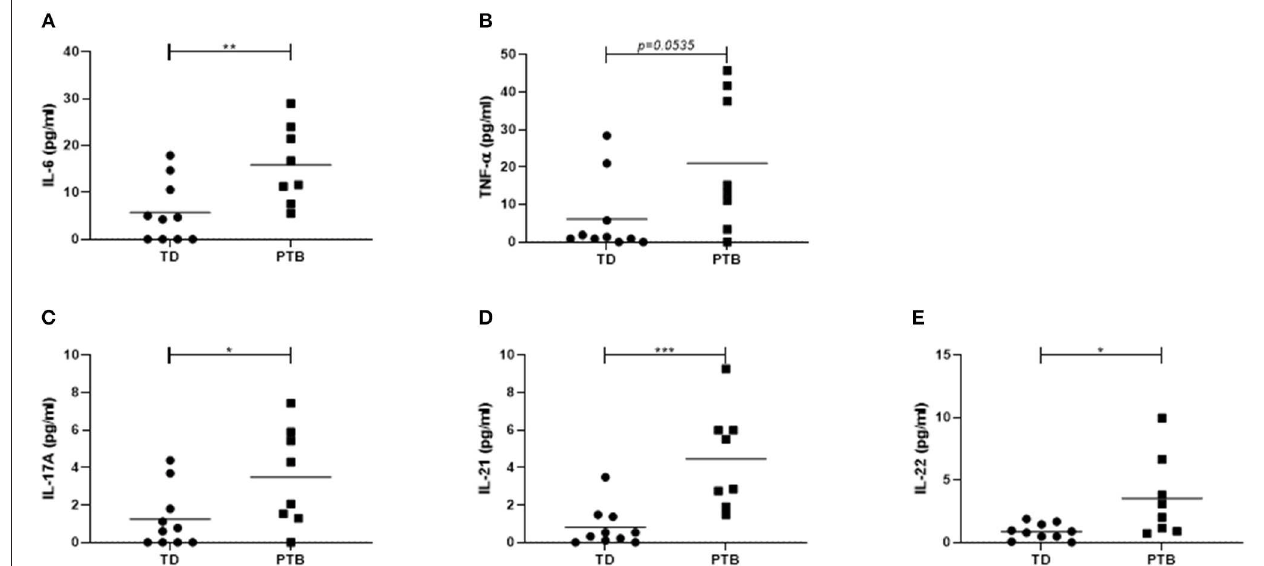
FIGURE 1 | Cytokine level in maternal plasma. Maternal plasma was taken immediately before delivery. Cytokine levels were determined using a Th panel multiplex bead-based assay. The levels of IL-6 (A) , TNF- α (B) , IL-17A (C) , IL-21 (D) , and IL-22 (E) were presented. Shown are the individual values and the mean. Data were analyzed by Mann-Whitney test; * p < 0.05; ** p < 0.005; *** p <